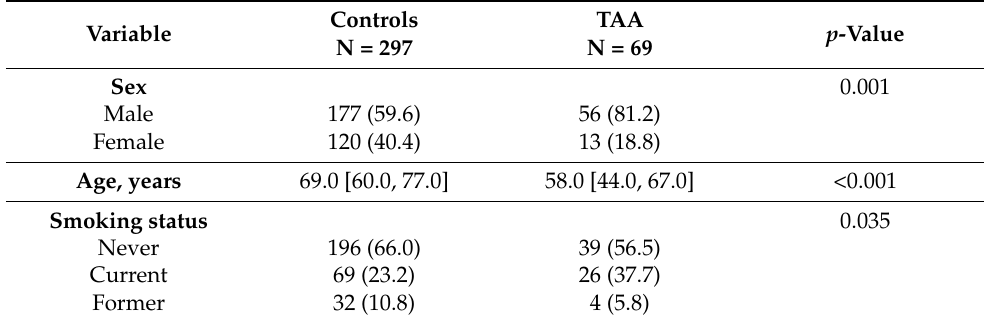
Table 1. Characteristics of the study